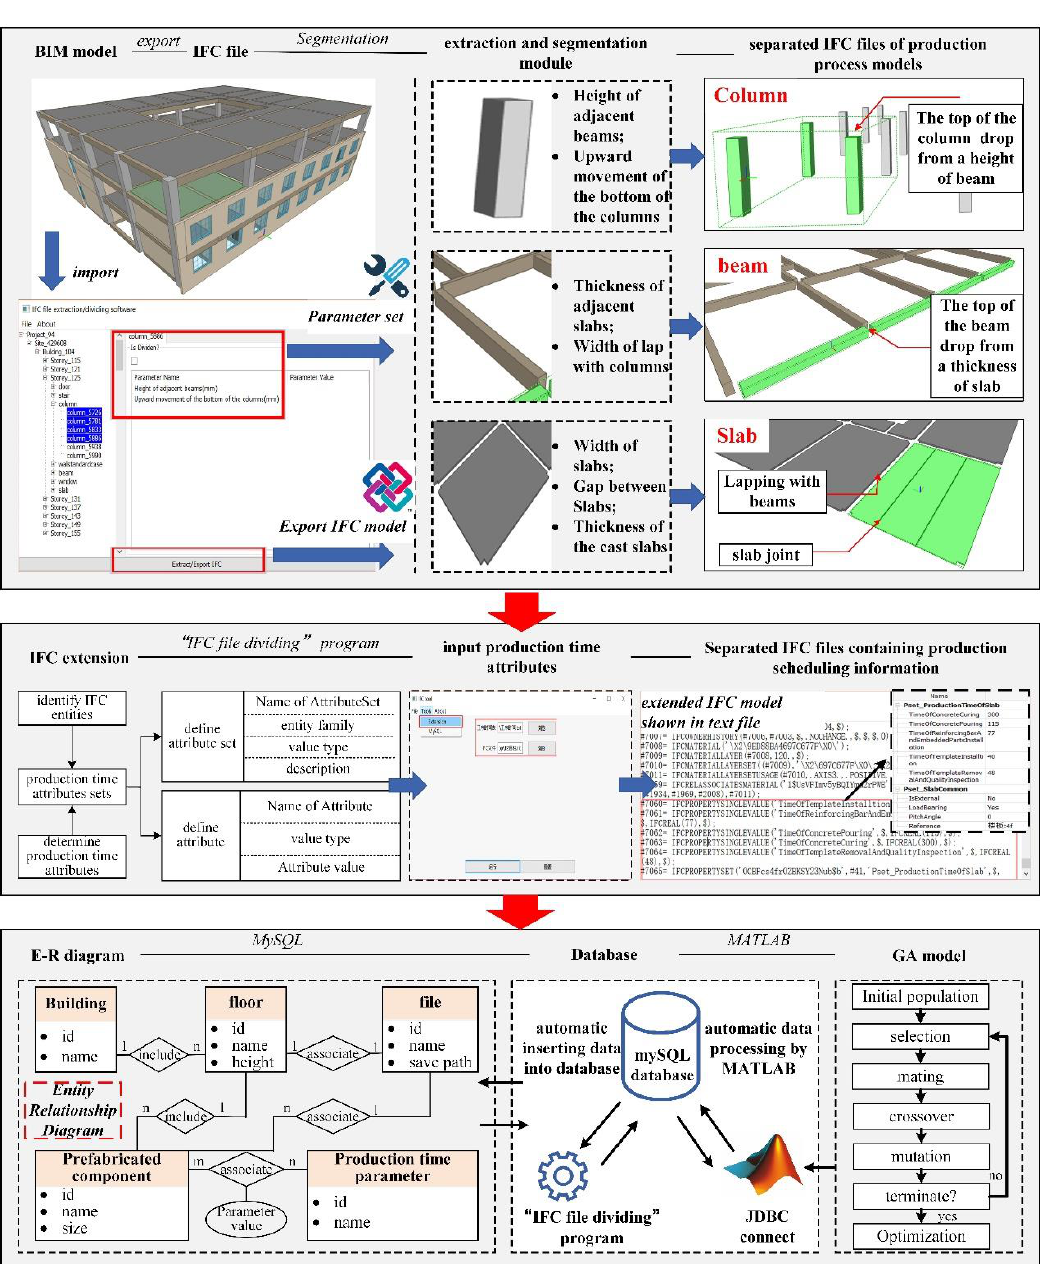
Figure 20. The overflow of the automated optimization framework.